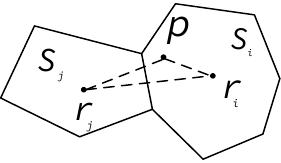
Figure 2. The principle of boundary contour extraction based on supervoxel. 𝑆 𝑖 and 𝑆 𝑗 are two supervoxels, respectively. 𝑟 𝑖 and 𝑟 𝑗 are representative points of supervoxel 𝑆 𝑖 and 𝑆 𝑗 , respectively.